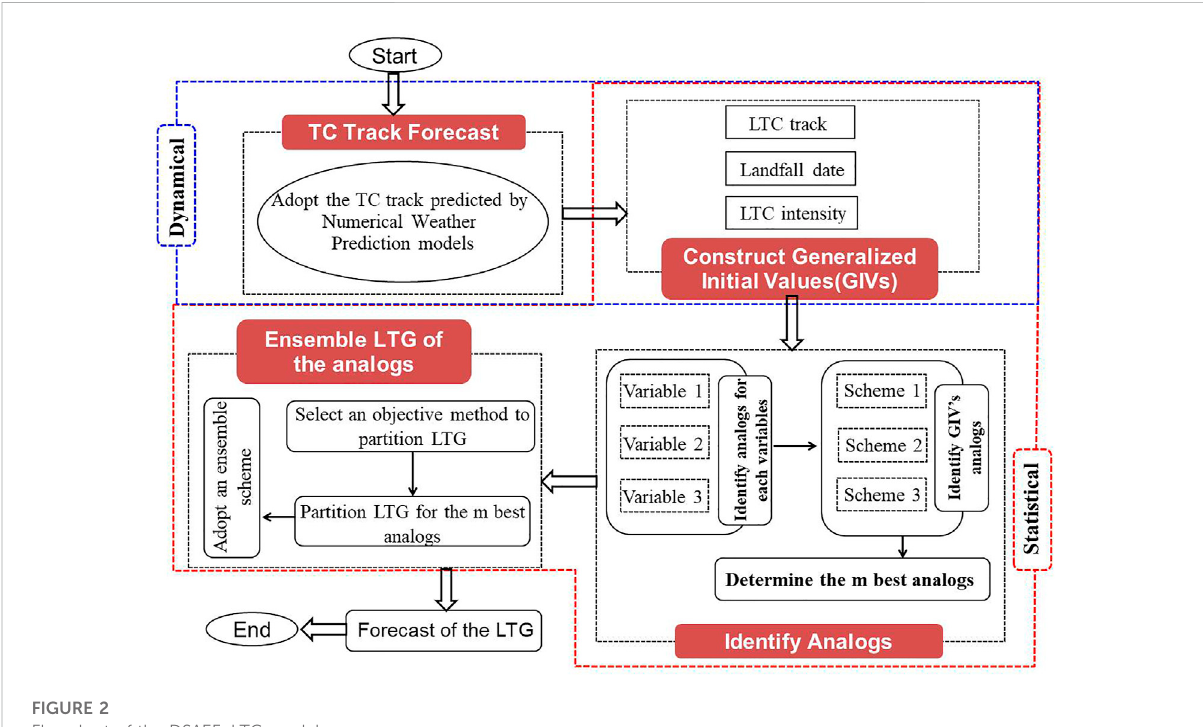
FIGURE 2 Flowchart of the DSAEF_LTG